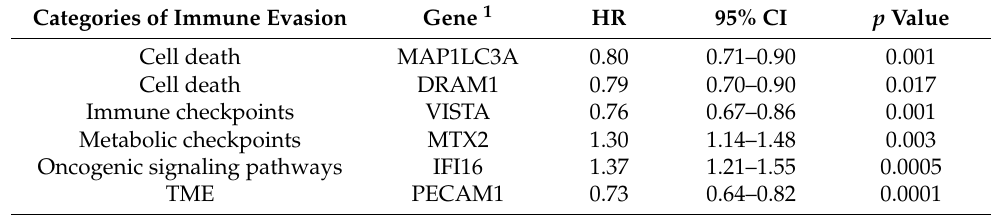
Table 3. Cox regression analysis for OS per individual